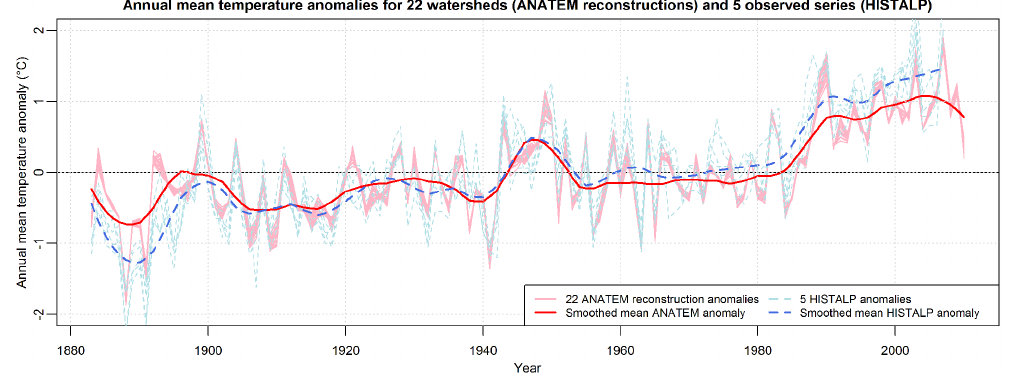
Figure 15. Mean annual air temperature additive anomaly for the 22 watersheds (ANATEM) and five stations (HISTALP). The additive anomaly for a given year has been computed as the difference between the annual temperature for this year and the 1883–2010 mean.